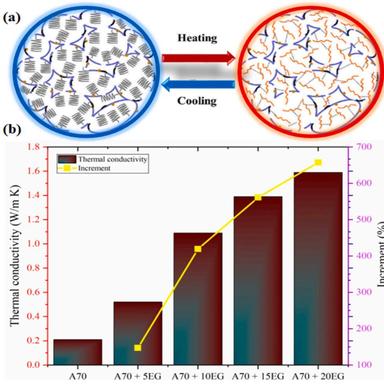
Schematic representation of (a) heat transfer mechanism of SS-PCM composite and (b) thermal conductivity of SS-PCM composites at different wt% of EG nanoparticles.